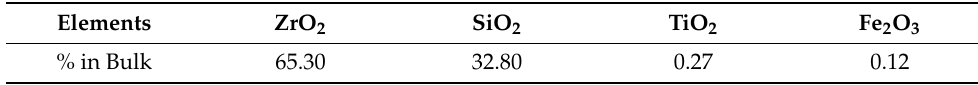
Table 2. Chemical composition of the zircon sand (ZrSiO 4 ).